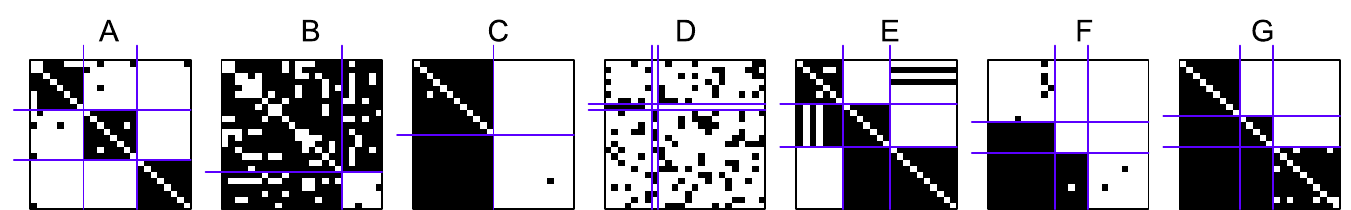
Fig 10. Some examples of generated networks for each type of a blockmodel. The networks are generated using the RL algorithm by selected allowed types of triads. (A) cohesive; (B) symmetric core-periphery; (C) asymmetric core-periphery; (D) hierarchical without complete blocks on the diagonal (E) hierarchical with complete blocks on the diagonal; (F) transitivity without complete blocks on the diagonal; (G) transitivity with complete blocks on the